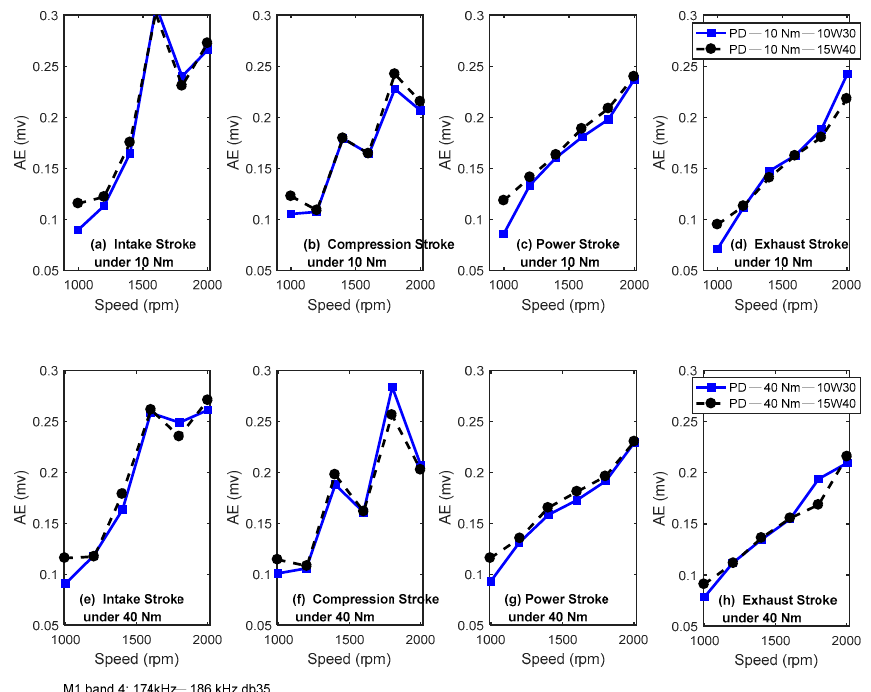
Figure 11. AE indicators from 174 kHz to 186 kHz for four strokes under different operating conditions.